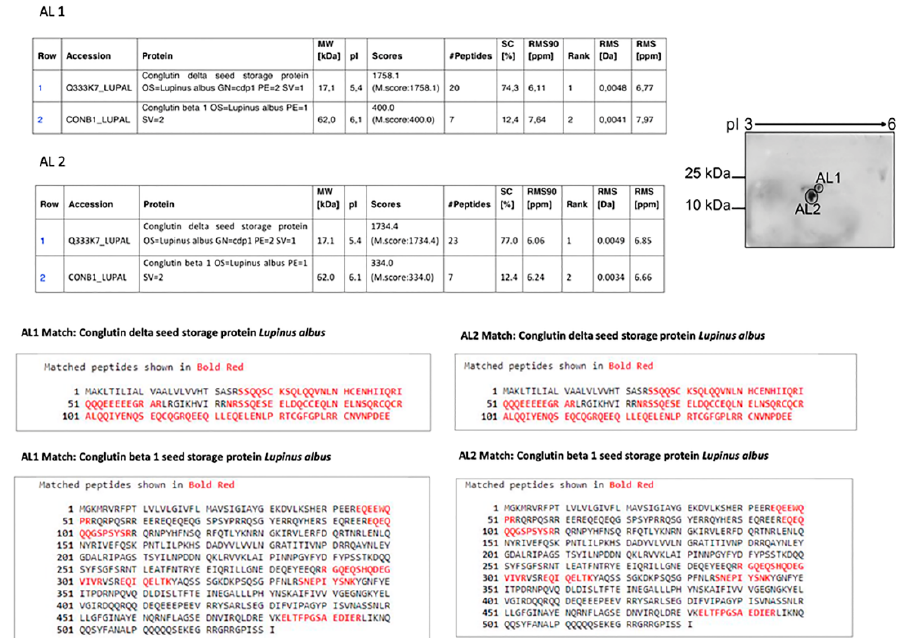
Figure 3. Amino-acid sequence of the L. albus MMPI. Mass spectrometry analysis of the isolated MMPI spots obtained from 2D analysis, AL1, and AL2, respectively, as demonstrated on the top right. The matched peptides are shown in red.